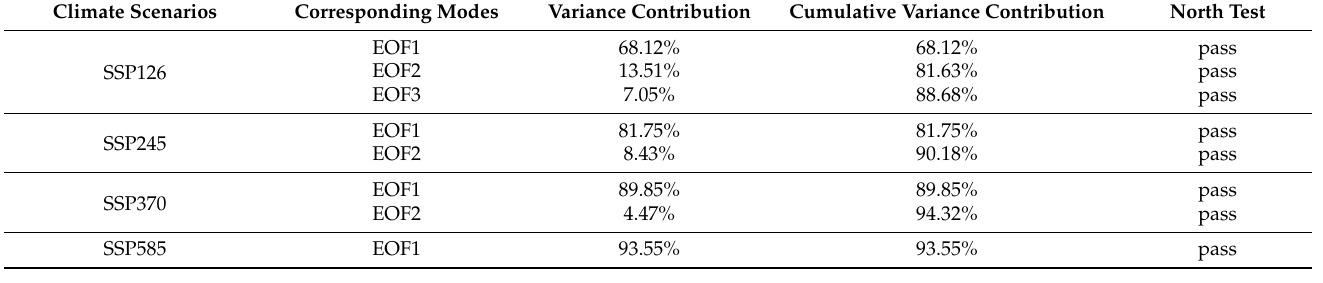
Table 2. Main modes and contributions of ET 0 under future climate scenarios in EOF analysis.